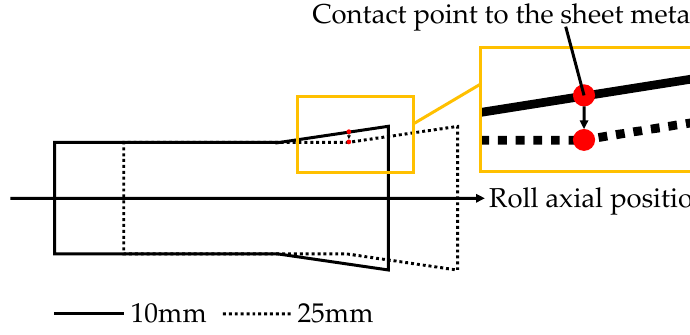
Figure 11. Contact pressure: ( a ) axial position δ = 10 mm and ( b ) axial position δ = 25 mm.